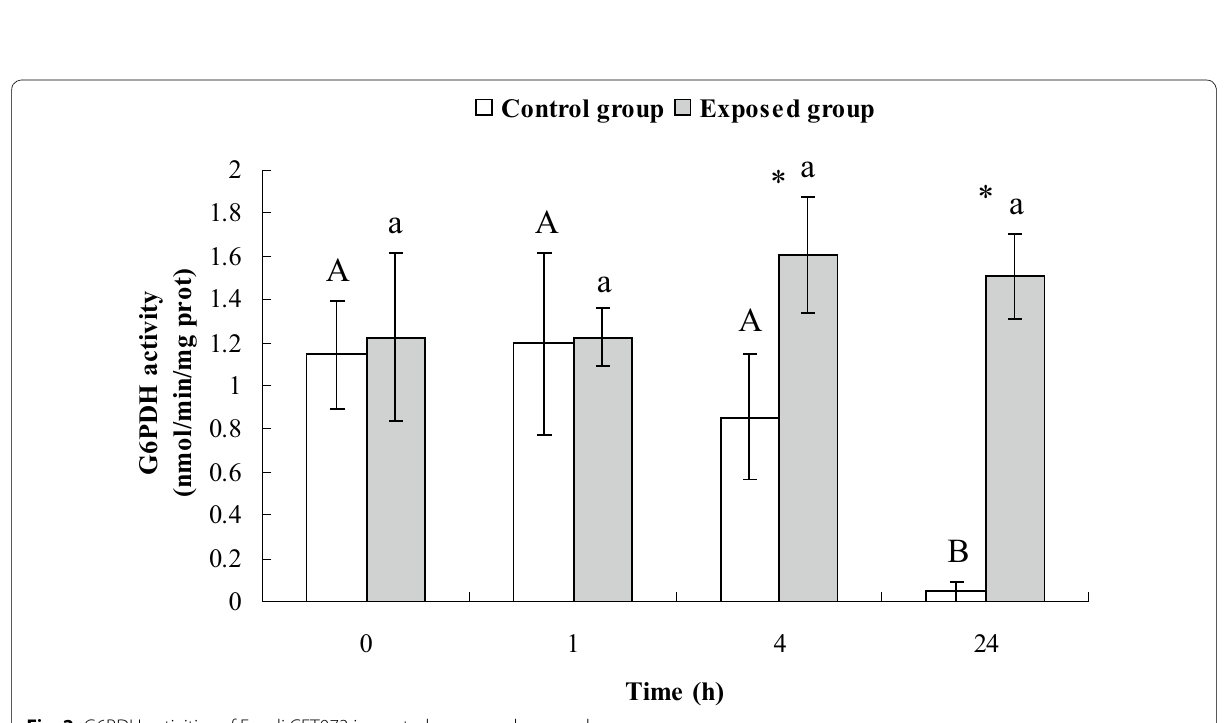
Fig. 2 G6PDH activities of E. coli CFT073 in control group and exposed